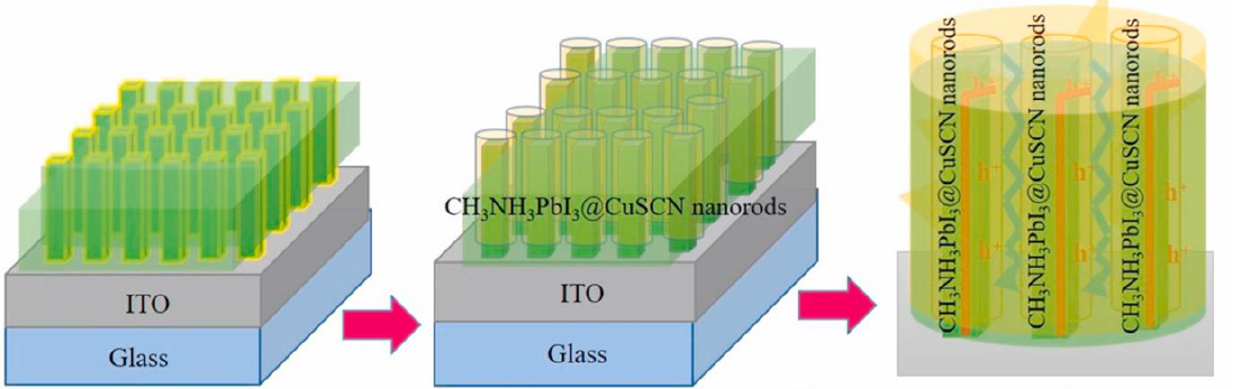
Figure 9. Schematic diagram of the formation of CuSCN@MAPbI 3 core − shell NRs. Reproduced from [131], with permission from the Organic Electronics, 2021.